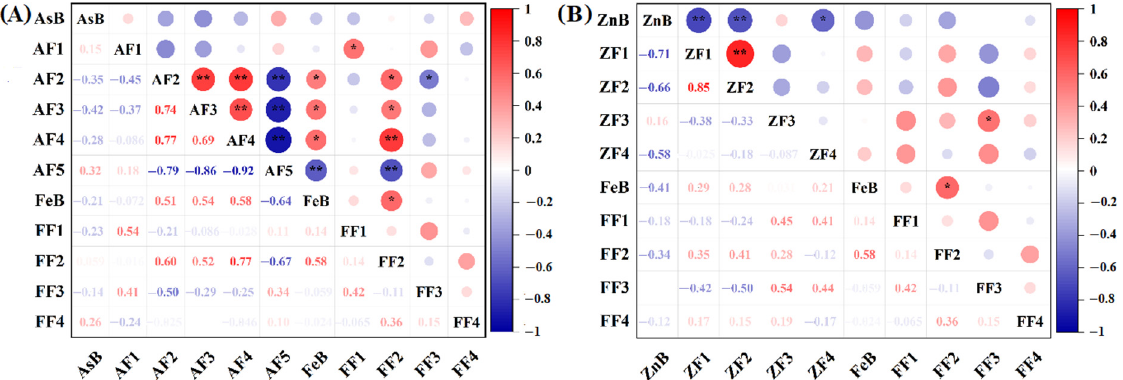
Figure 4. The correlation coefficients of different species of As ( A ) and Zn ( B ) with Fe fractions in soils. AsB: As bioaccessibility, AF1: non–specifically bound As, AF2: specifically bound As,